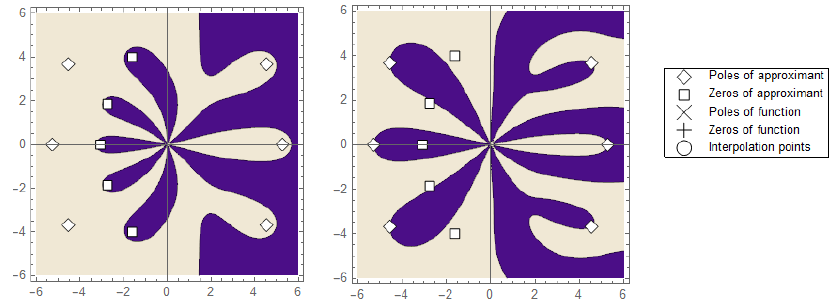
Figure 2. The plot of order stars of the first kind ( right ) and the order stars of the second kind ( left ) using the proposed one-step optimized block technique presented in Equation